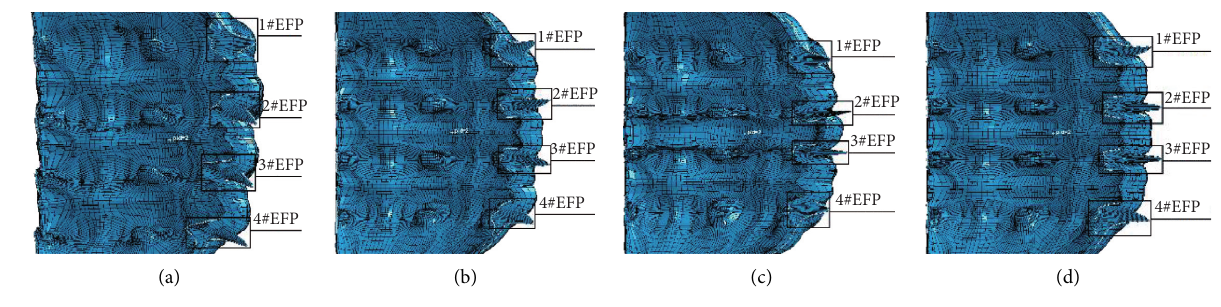
Figure 6: Forming